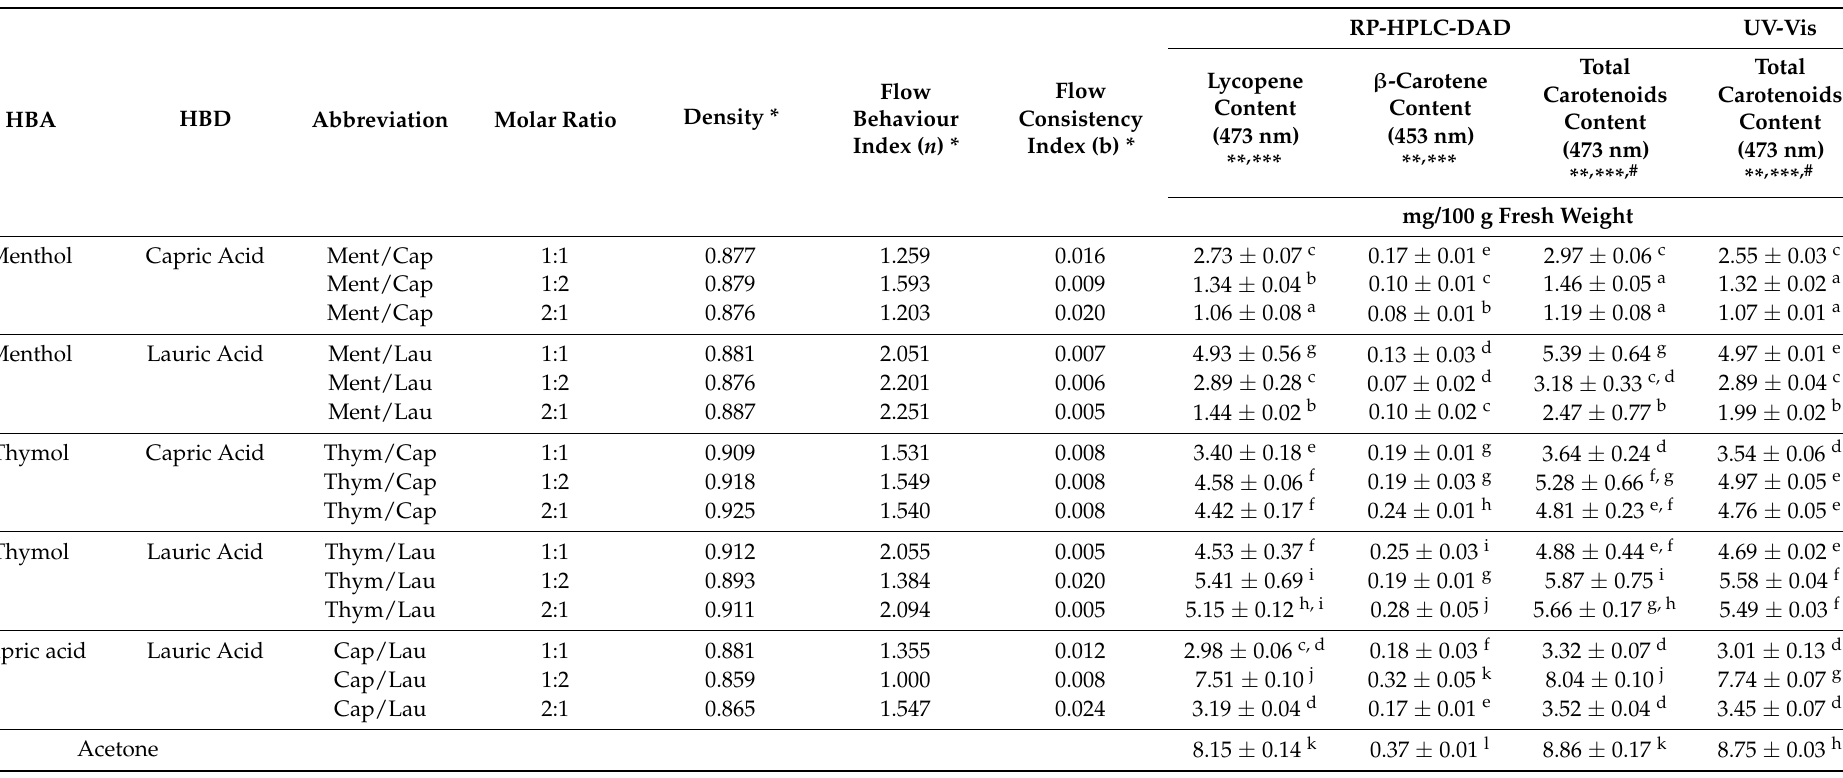
Table 1. Abbreviations, molar ratios and physicochemical characterisation of the prepared HNADESs, and tomato carotenoids content (mg/100 g fresh weight), as determined by RP-HPLC-DAD and UV-Vis spectrophotometry after extraction with different HNADESs during the screening